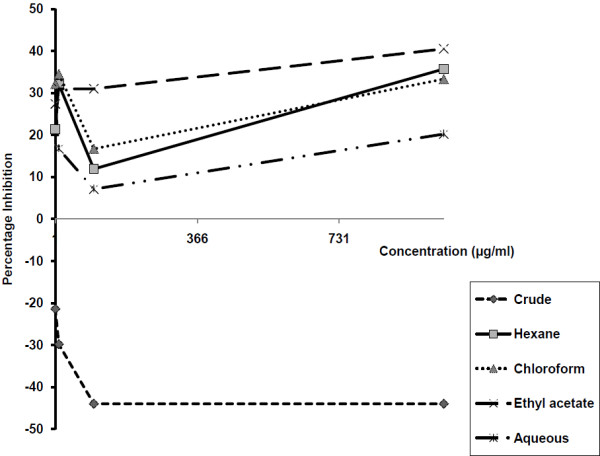
Percentage inhibition of monkey kidney cells lines maintained in culture for one day before exposure to Euphorbia hirta extracts for 5 days1. 1. Percentage inhibition of potassium cyanide (KCN) at 103 μg/ml = 131%; the optical density (OD) values for: 1% DMSO (solvent control) = 0.069, cells cultured in plain culture medium = 0.093, and for heat killed cells = −0.015 (negative figures imply promotion of cell maintenance).